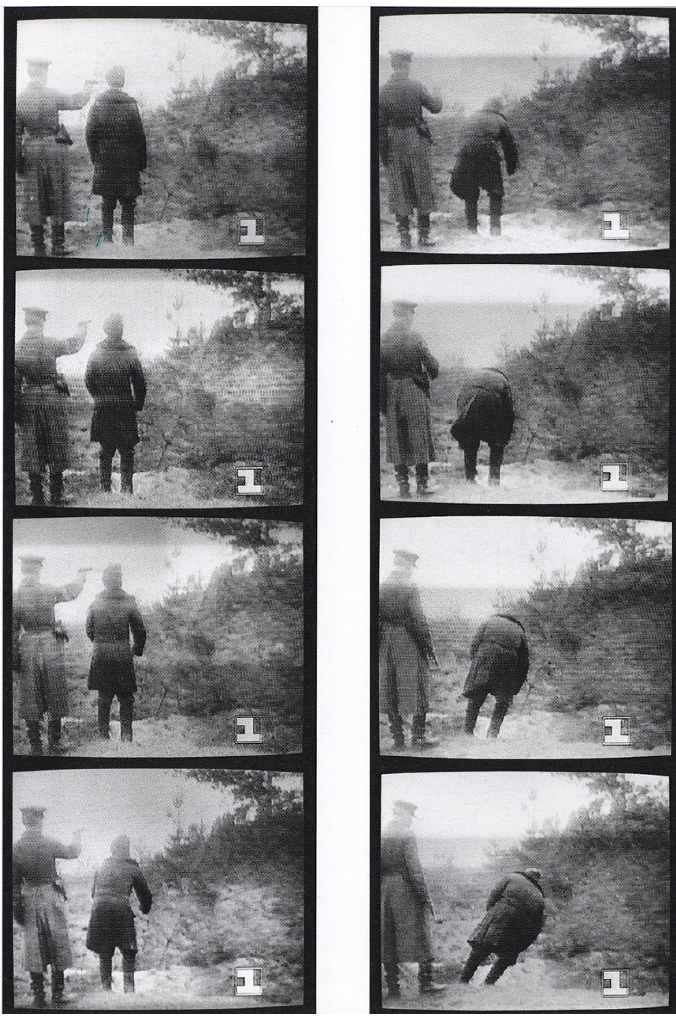
Figure 4. Kulik, guide, 1997. Assassination (TV screen photos).